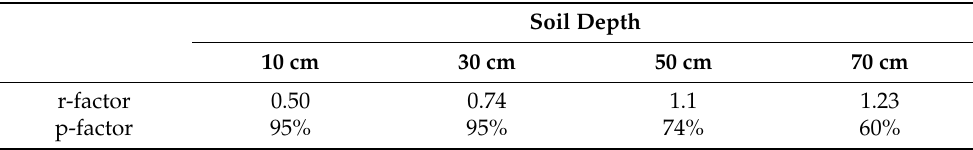
Table 8. Evaluation of the predictive uncertainty of the HYDRUS-1D model regarding soil salinity dynamic simulations.